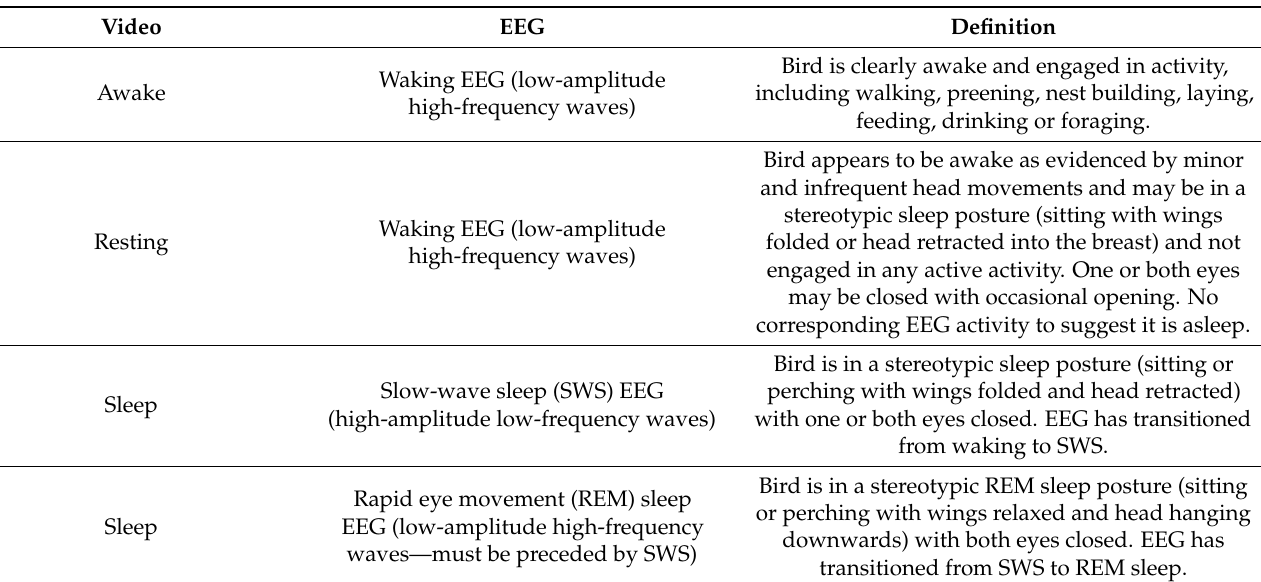
Table 4. Ethogram of sleep behaviour assessment criteria and corresponding electroencephalograph (EEG)